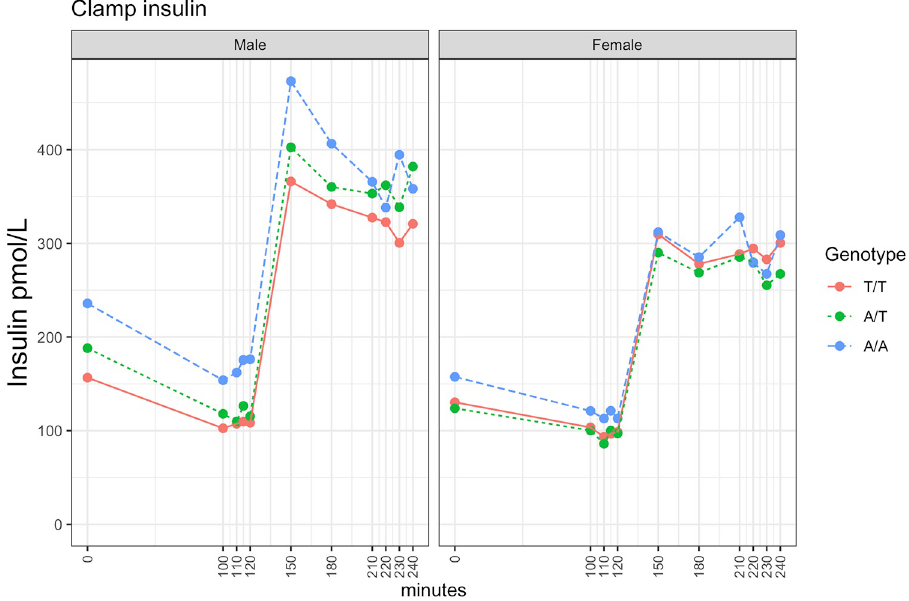
Fig 3. Median serum insulin concentration over time during clamp by sex and genotype. Insulin infusion started at 120 min. Kruskal-Wallis p -values for testing for difference in insulin concentration between genotypes at basal time (average of 110, 115 and 120 min) were 0.33 (males) and 0.40 (females) and clamped time (average of 220, 230 and 240 min) were 0.35 (males) and 0.80 (females). Males in left panel, females in right panel.